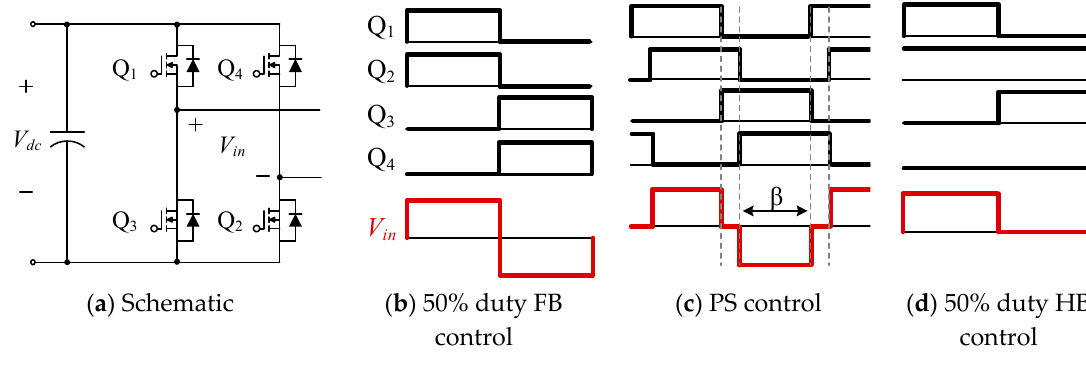
Figure 2. Schematic and control modes of full-bridge inverter. Table 2. Comparisons of voltages, currents, and their load dependency.